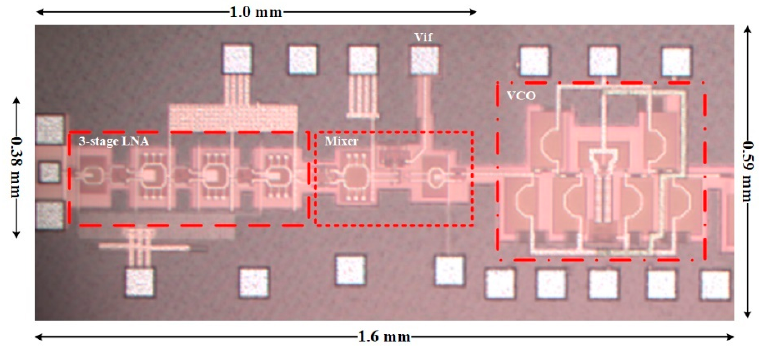
Figure 14. The chip photograph of the receiver.